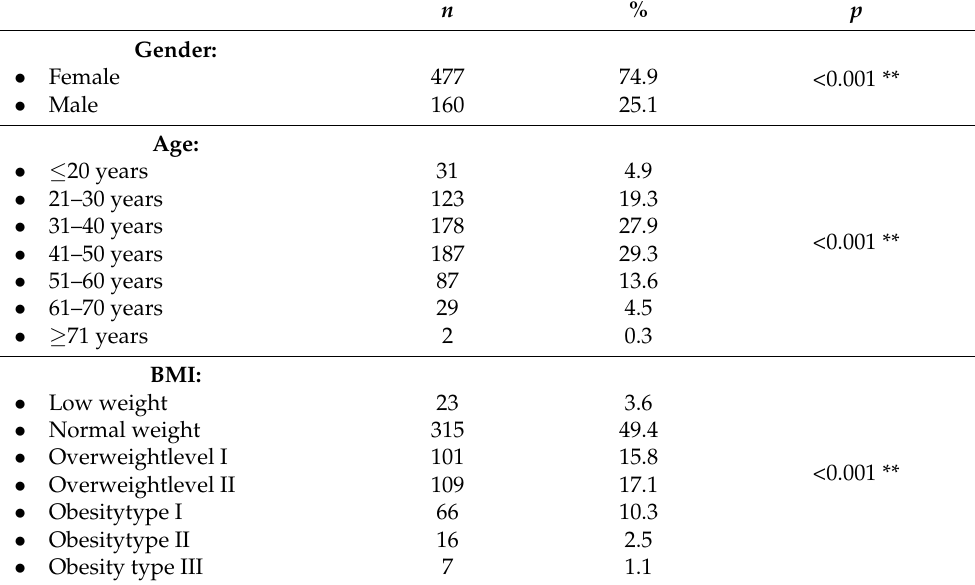
Table 1. Sociodemographic and anthropometric